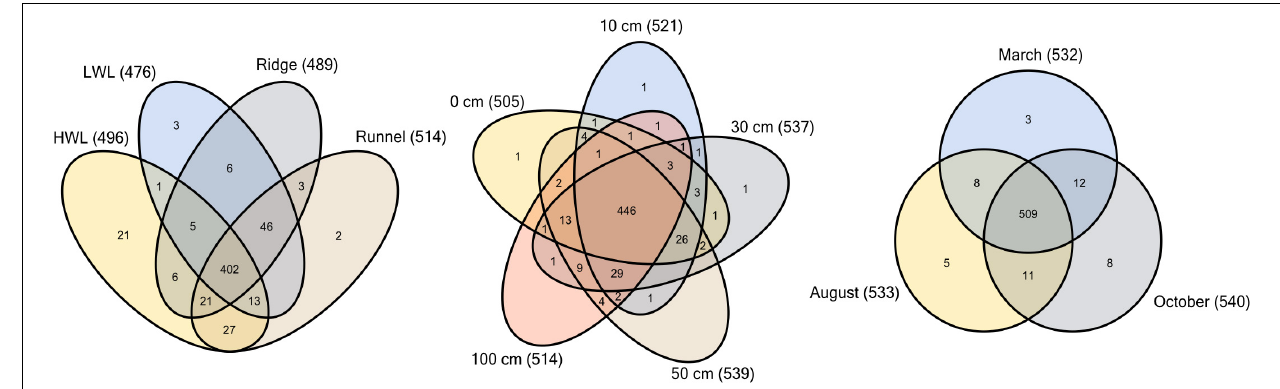
FIGURE 4 | Distribution of individual microbial species within sediment samples of Spiekeroog beach. Venn diagrams show comparisons of the sampling depths ( n = 26), sites ( n = 30, LWL n = 40) and campaigns ( n = 40, October n = 50). Diversity is based on ZOTUs with assigned taxonomy using the SILVA